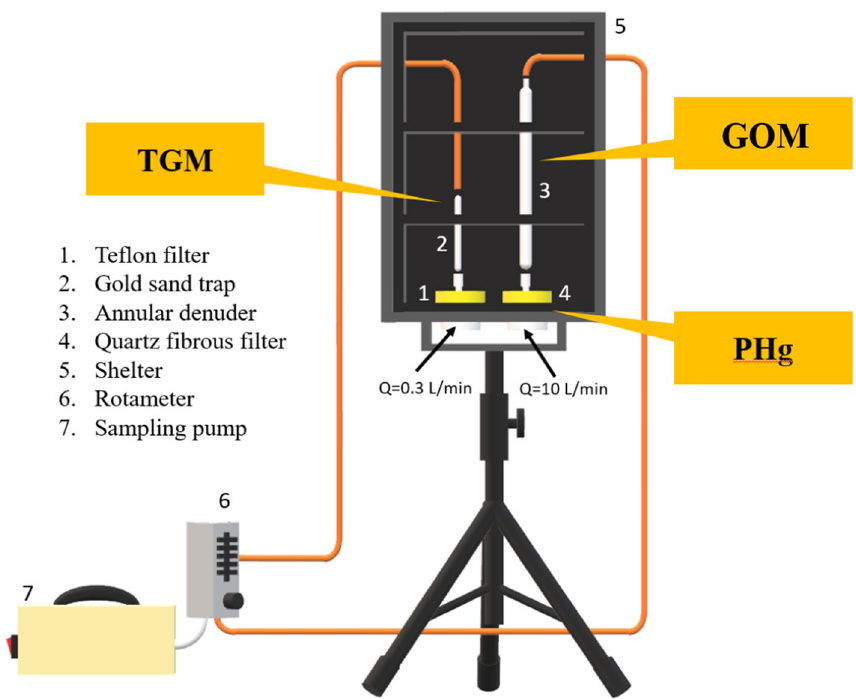
Figure 2. Schematic diagram of atmospheric speciated mercury sampling system for field measurement at the Taiping Island in the South China